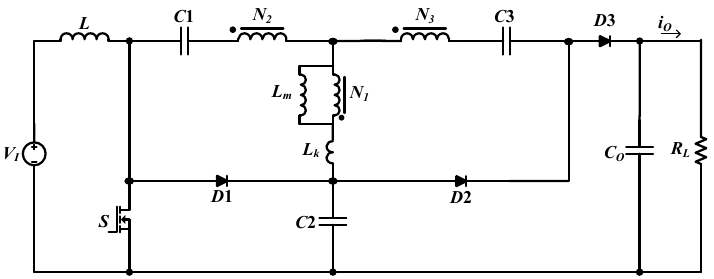
Figure 1. The circuit configuration of the presented structure.